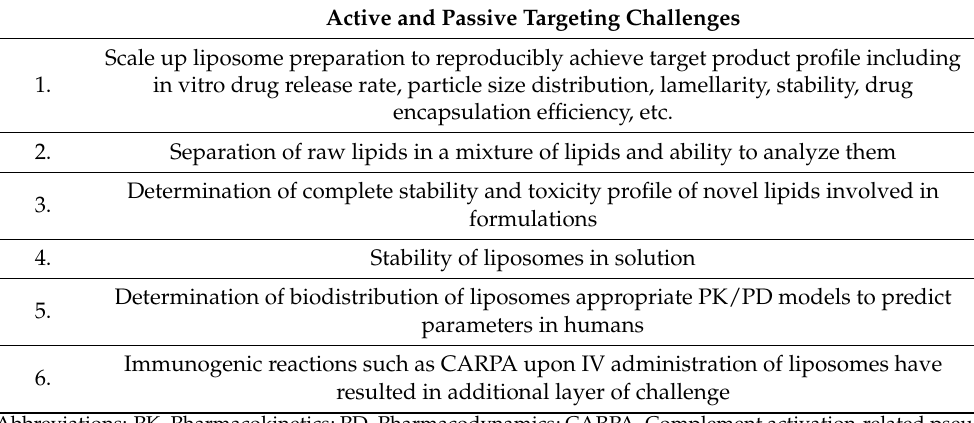
Table 2. Challenges common to both active and passive